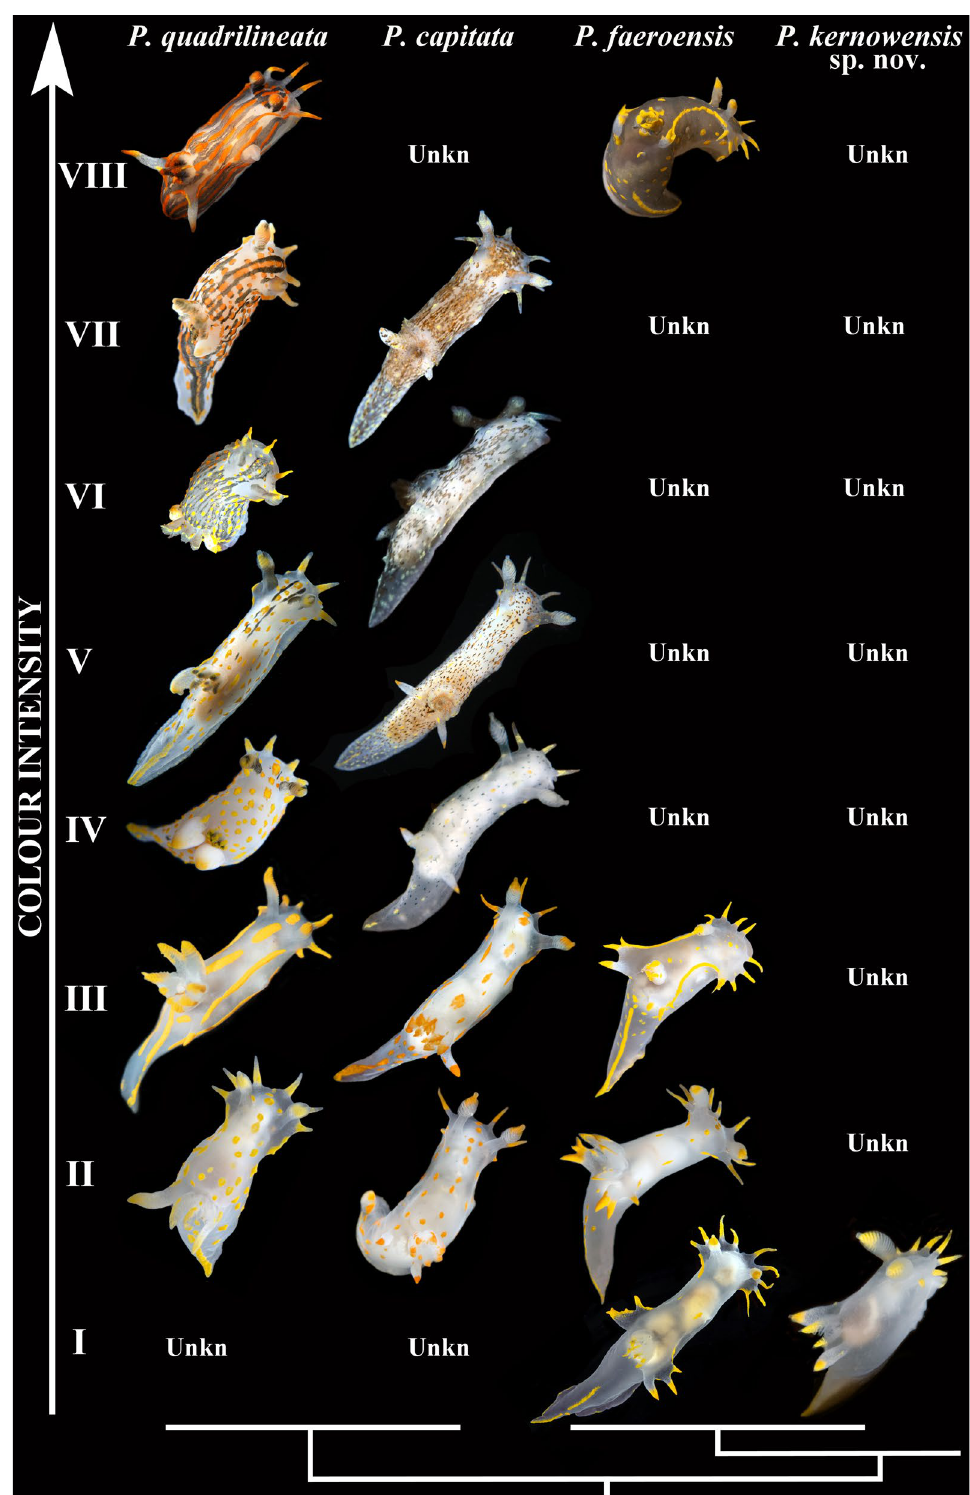
Figure 1. Periodic-like presentation of chromatic variation patterns among species within European Polycera , represented as vertical rows. Eight main periods (horizontal rows, roman numerals) are presented whereas spotless body/colourless forms are at the bottom and forms with a maximal number of spots/coloured are at the top. Non-observed forms for each particular species are indicated as “unkn” =